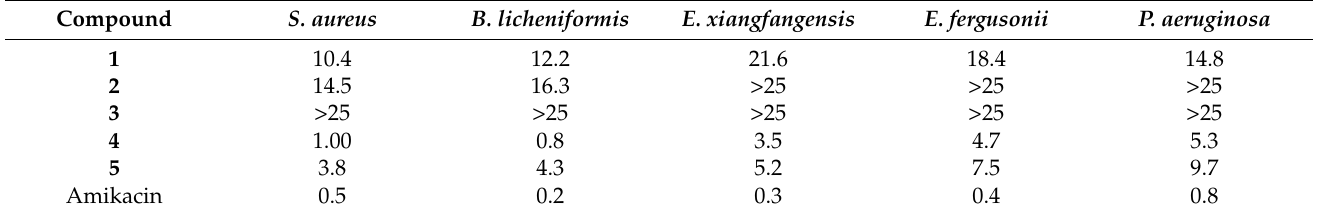
Table 1. Antibacterial Activity of Compounds 1 – 5 Expressed as MIC ( µ g/mL)